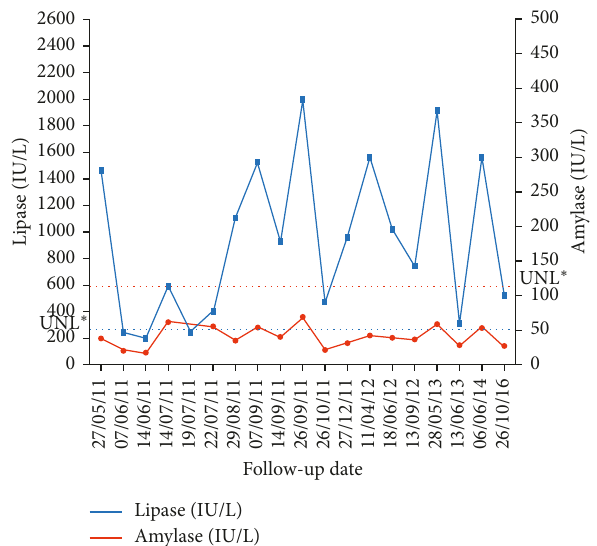
Figure 2: Serial follow-up of serum lipase and amylase levels in Upper normal postmenopausal women. ∗